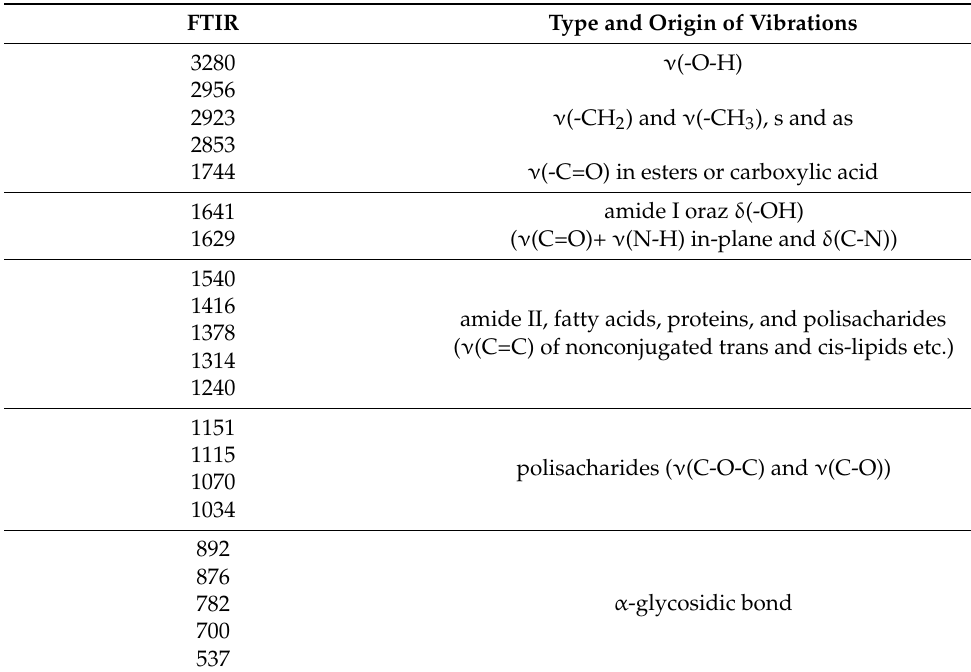
Table 5. The location of the maxima of the Fourier Transform Infrared (FTIR) absorption bands, with assignment of particular vibrations to the respective samples, registered within the spectral range of 700–3700 cm − 1